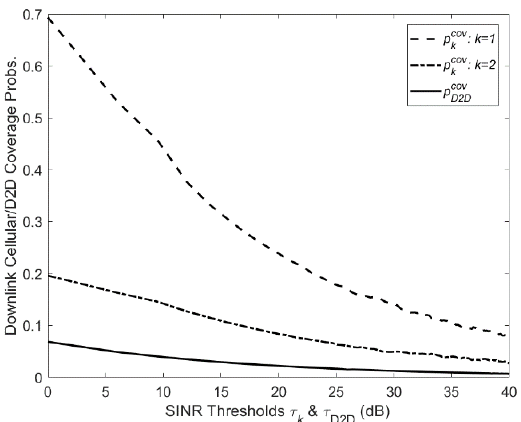
Figure 12. The average downlink cellular/D2D coverage probabilities (i.e., 𝑝 𝑘𝑐𝑜𝑣 (𝑐)̅̅̅̅̅̅̅̅̅̅ and 𝑝 D2D𝑐𝑜𝑣 ̅̅̅̅̅̅ ) in underlay in-band D2D mode and when the PSA policy is used vs. the corresponding SINR thresholds 𝜏 𝑘 ( 𝑘 ∈ 𝒦 ) and 𝜏 D2D .